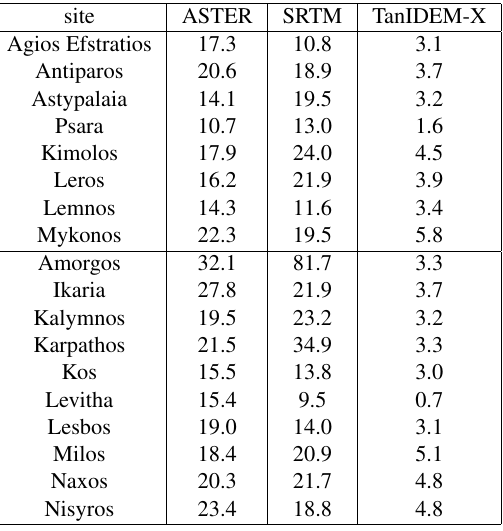
Table 8. RMSE (m) of the global DEMs with respect to local elevation data. (DX,DY,DZ) as shown in Tables 5,